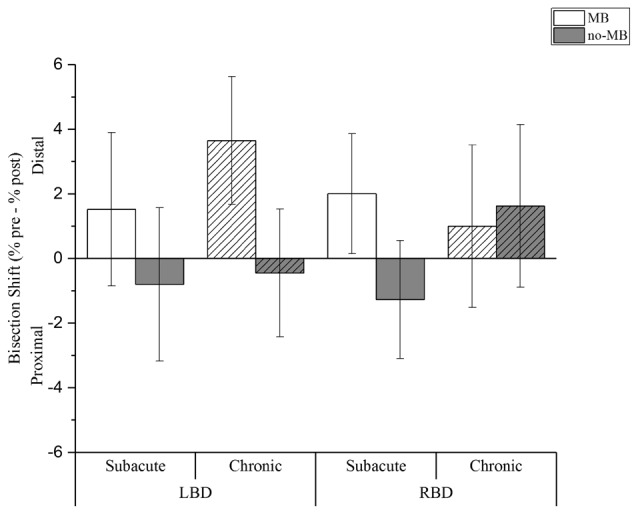
Experimental results. Columns indicate the shift (%) of the perceived forearm midpoint calculated as pre-training performance minus post-training performance. Positive values indicate a shift of perceived midpoint towards the hand (i.e., distal deviation), negative values indicate a shift of perceived midpoint towards the elbow (i.e., proximal deviation). Light columns show the results for the MB training condition, dark columns for the no-MB training condition. Full color columns show results for subacute groups, diagonal lines pattern columns represent the chronic groups. Thin bars indicate Confidence Intervals (CIs) set at 95% level.